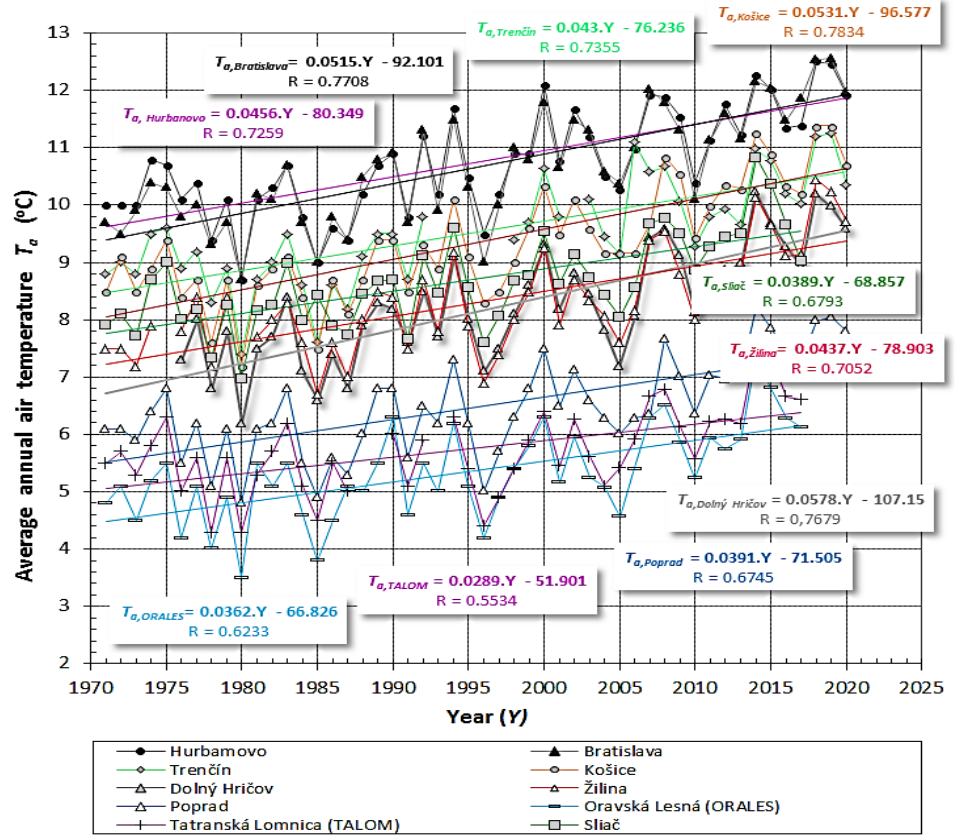
Figure 5. Development of the average annual air temperature of 10 climatological stations in Slovakia at an altitude of 115 to 858 meters above sea level for the period 1971 to 2020. Table 2. Average annual temperature T a calculated for the periods 1971 – 2000, 1971 – 2010, and 1971 –